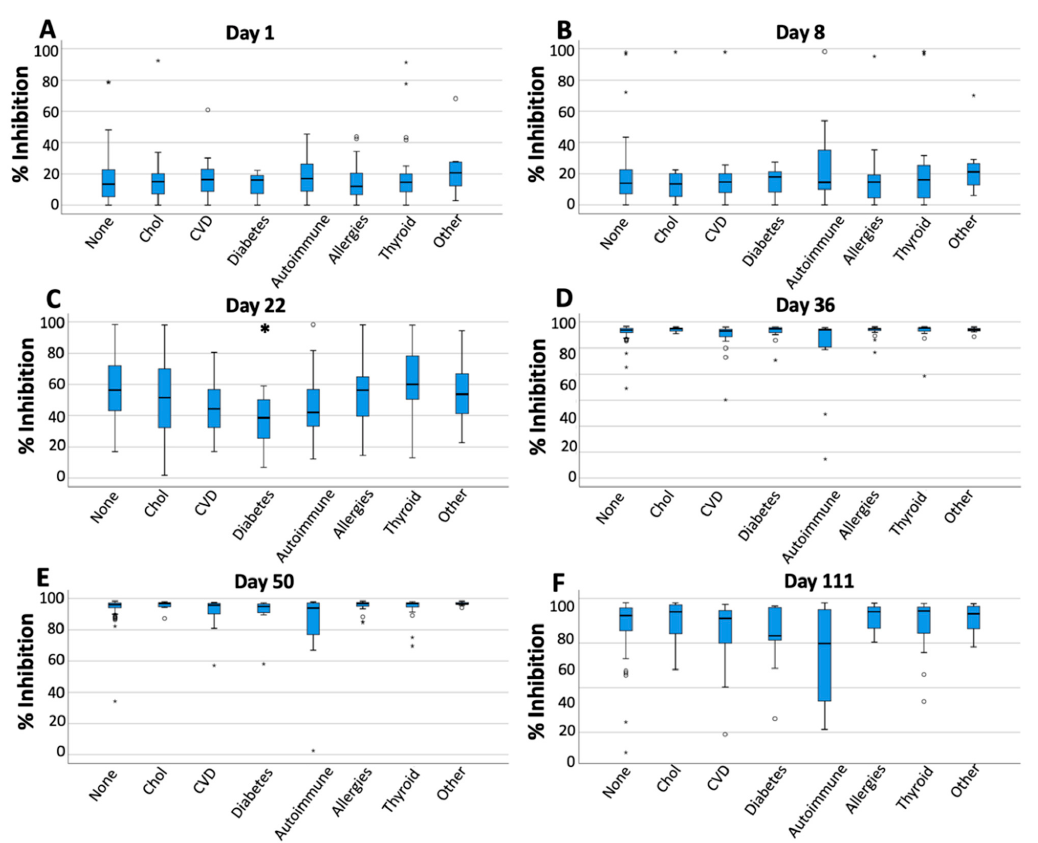
Figure 7. Inhibition (%) of SARS-CoV-2 binding at measurement days (1, 8, 22, 36, 50, 111) divided according to the medical history of the subjects participating in the study. On day 22 (plot ( C )), subjects with diabetes, cardiovascular problems, and autoimmune diseases had lower inhibition titers compared to the other groups. On this day, the difference was statistically significant ( p = 0.039) only for subjects with diabetes compared to individuals with no comorbidities. In all other cases, no statistically significant differences were observed. Key: Chol, hypercholesterolemia; CVD, cardiovas- cular disease. A ) Day 1, B ) Day 8, C ) Day 22, D ) Day 36, E ) Day 50, F ) Day 111; “°” and “*” denote extreme values